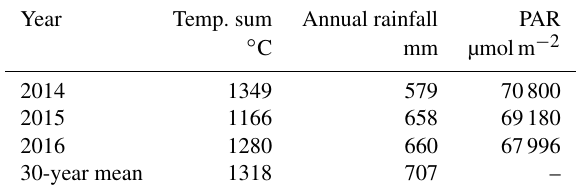
Table 1. Effective temperature sum of the growing season, an- nual rainfall and the cumulative photosynthetically active radiation (PAR) in the three studied years (2014–2016), compared to the 30- year averages of the area. Data for the Hyytiälä weather station are from Finnish Meteorological Institute open data. Temp.